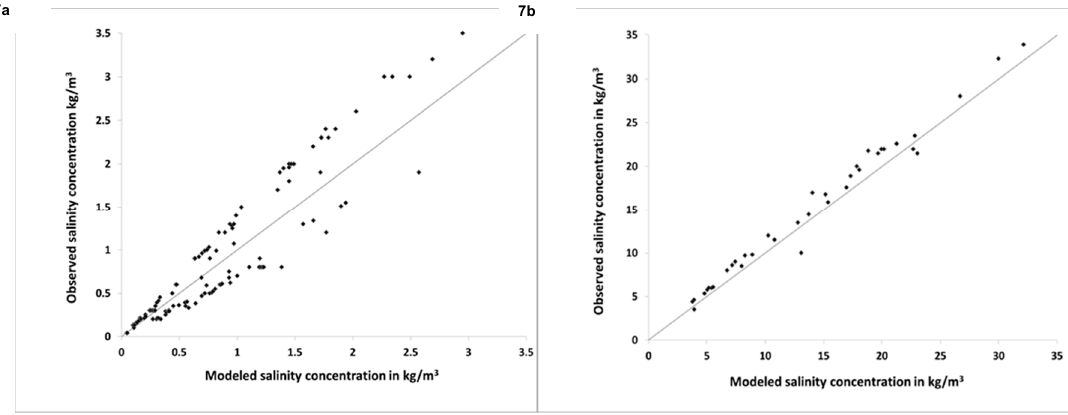
Figure 7. Modeled versus observed salinity concentrations in: ( a ) The southern and the middle parts of the NDA (RMSE = 0.8, Abs. Diff. = 0.52, Stan Dev. = 0.61kg/m 3 ). ( b ) The northern parts of the NDA year 2010 (RMSE = 0.2, Abs. Diff. = 0.14, Stan Dev. = 0.11kg/m 3 ).